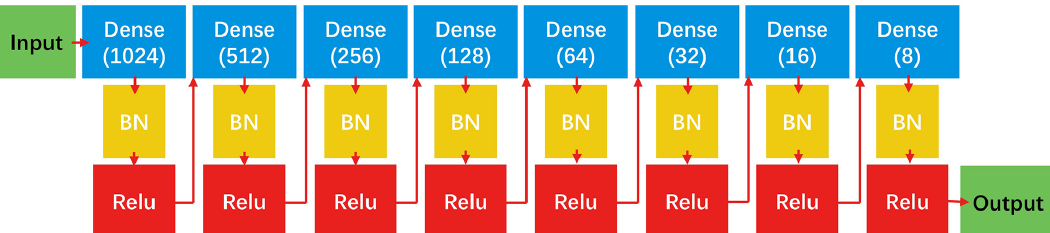
Figure 1. The structure of the deep artificial neural network built in this study. Each box represents one layer with neurons and weights to be passed to the next layer. In the densely connected layer (“Dense”), all neurons connect with neurons in the next layer, and the number of neurons is shown in brackets. In the batch-normalisation layer (“BN”), the data are normalised and passed to the next layer. The rectified linear unit (“Relu”) acts as a non-linear activation function. The arrows show the computation path from input to